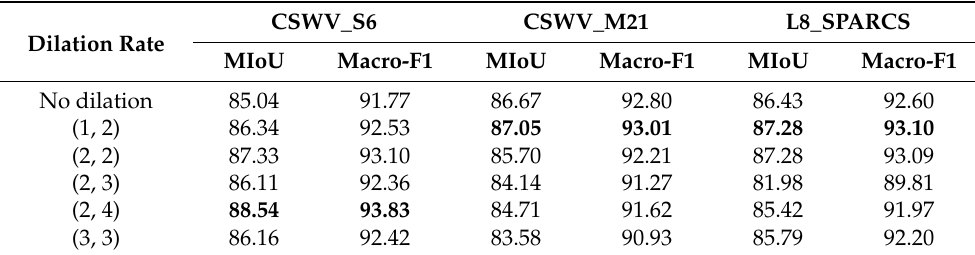
Table 6. Comparison of CSD-Net accuracy with different dilation rates.